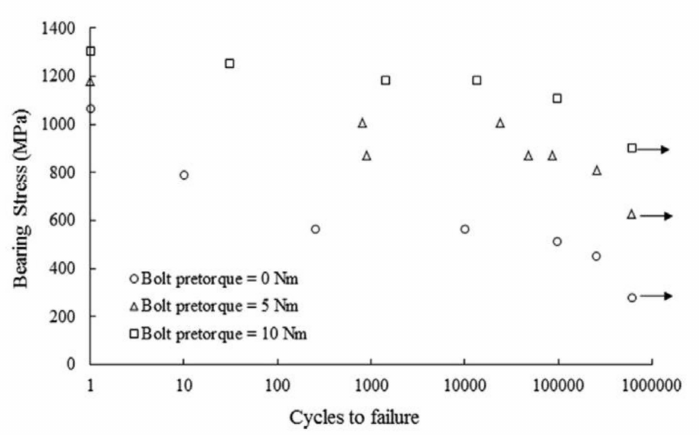
Figure 4. S–N graph at various bolt torque pre-tightening levels